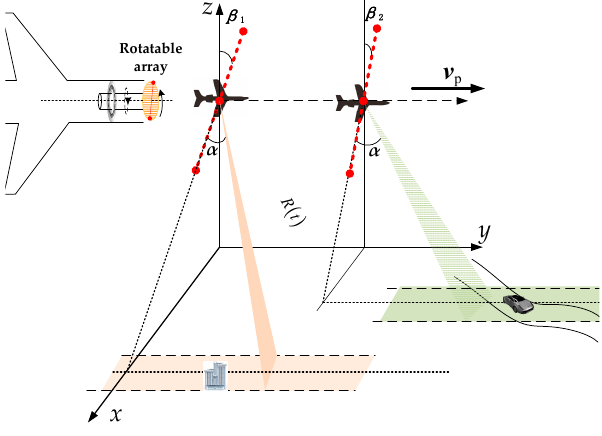
Figure 4. Ro-XTI-SAR system model with the rotatable forward-looking array.